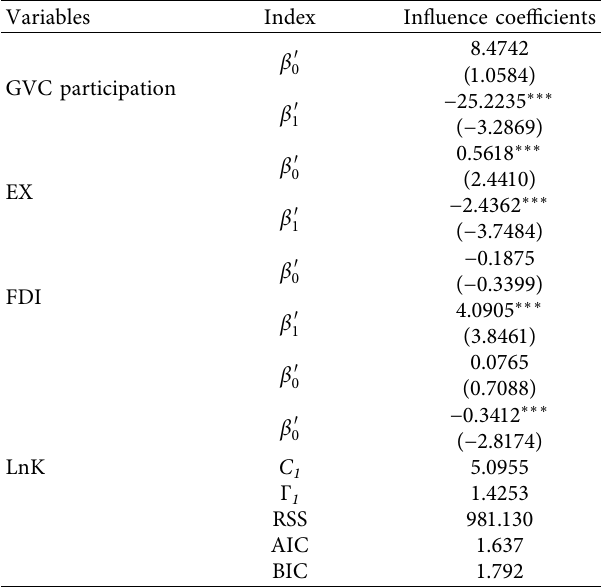
Table 7: Robustness